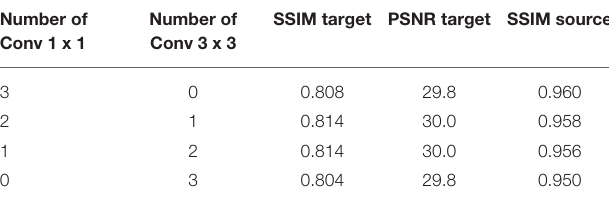
TABLE 6 | Evaluation metrics of different StainNet